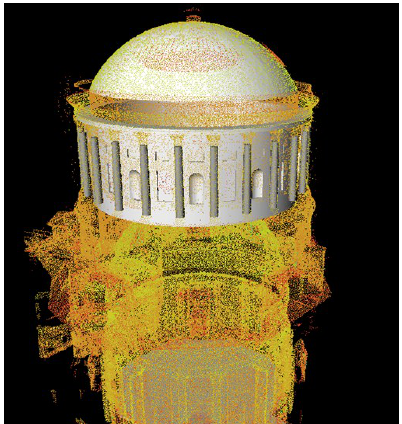
Figure 13: Procedurally Modelled Dome and Drum (Dore & Murphy